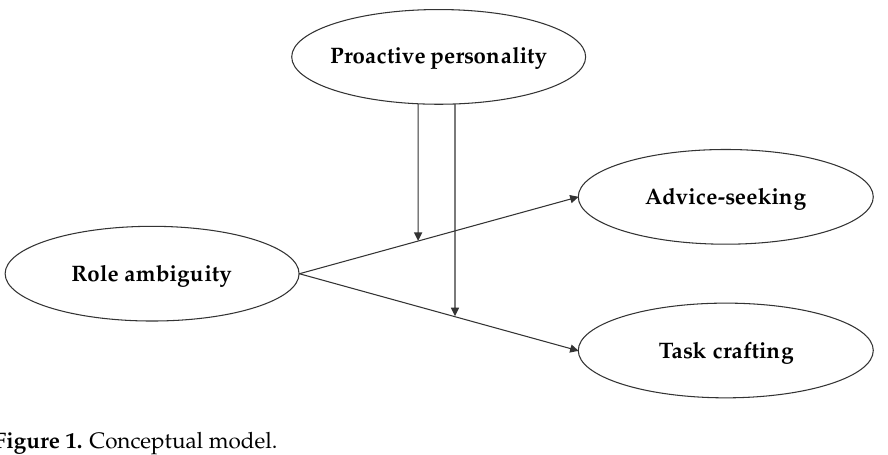
Figure 1. Conceptual model.